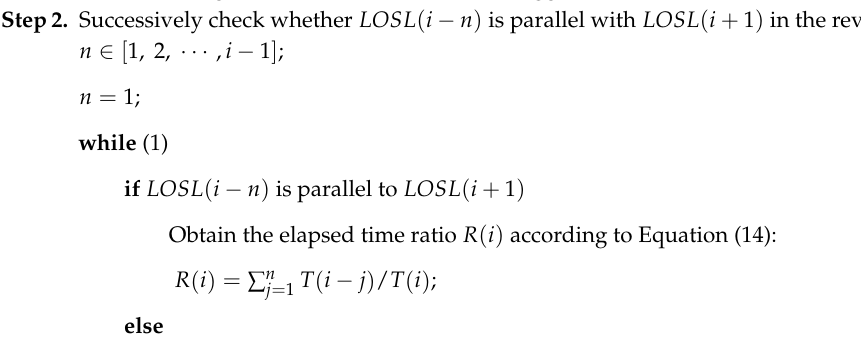
Algorithm 3: CP Estimation on LOSL ( i ) based on the Intercept Theorem. Initialization: Obtain the coordinates of all wireless sensor nodes, as well as the topology information of all LOSLs, that is, their